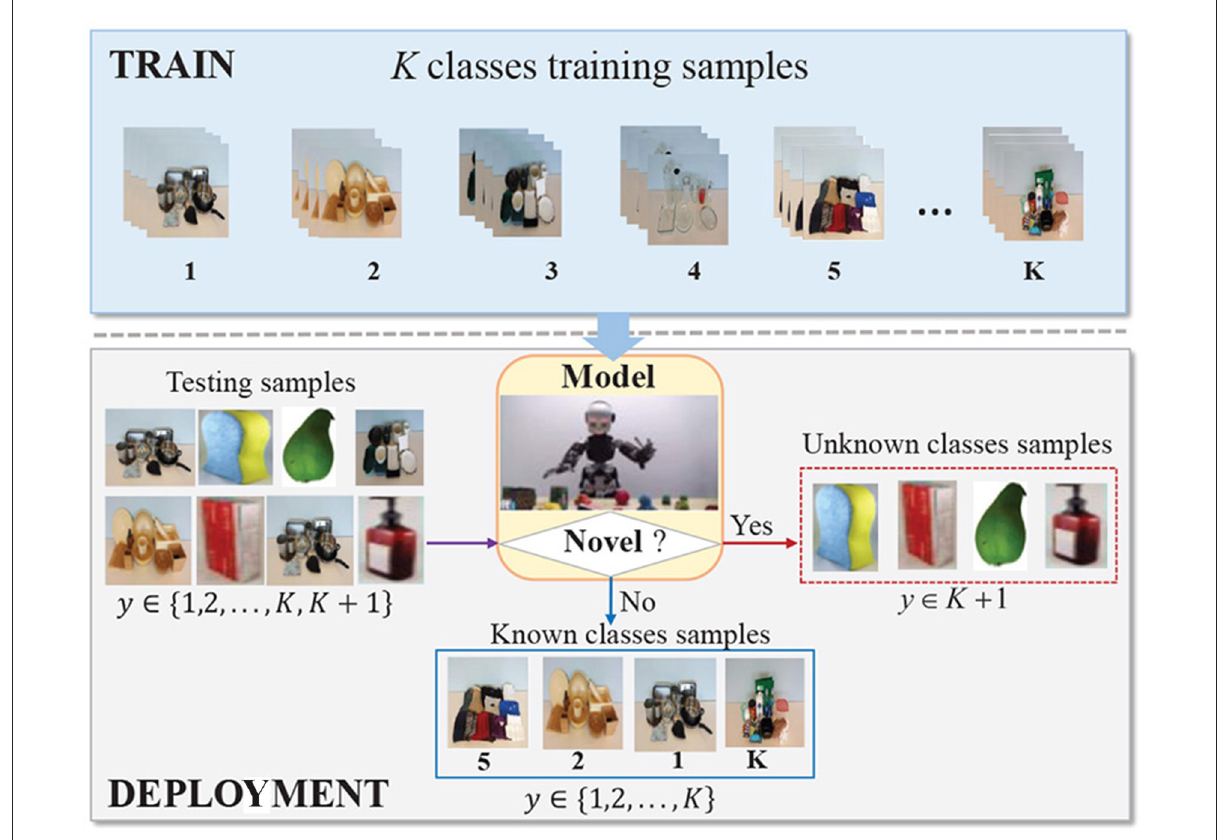
FIGURE1 The schematic of open-set tactile object recognition. Some images are from https://sites.gatech.edu/hrl/mr-gan/.